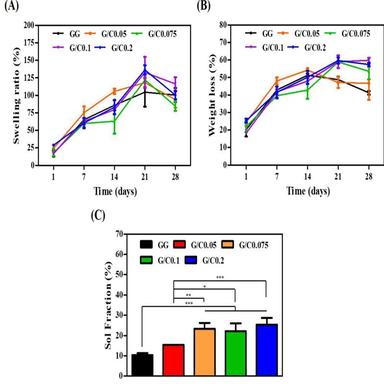
(A) Swelling ratio (%) (B) weight loss (%) and (C) sol fraction (%) of the hydrogels (values are mean ± SD, n = 3, P b 0.05 (\), P b 0.01 (\\), P b 0.001 (\\\)).